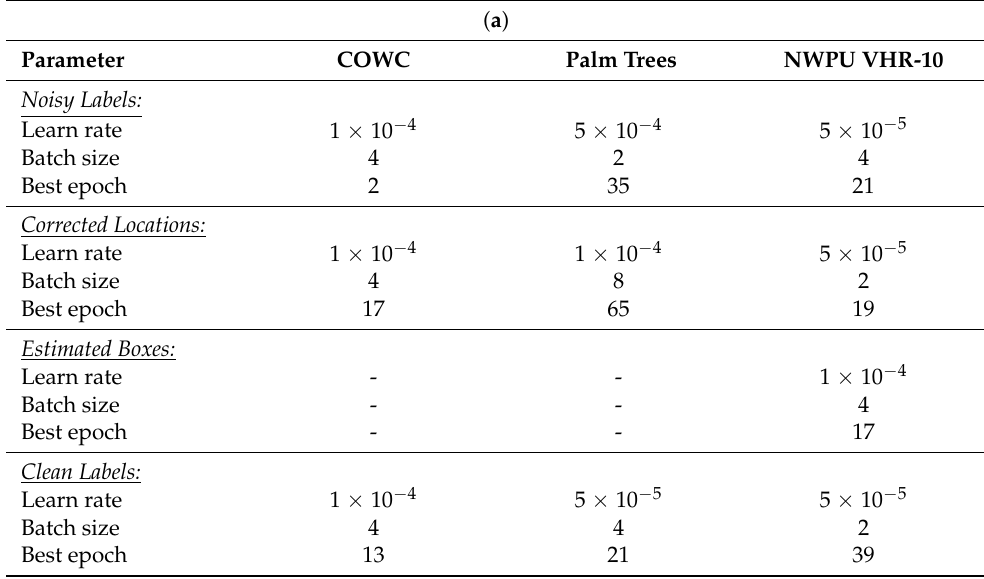
Table A3. Best hyperparameter settings for (noise-resistant) object detection methods: ( a )